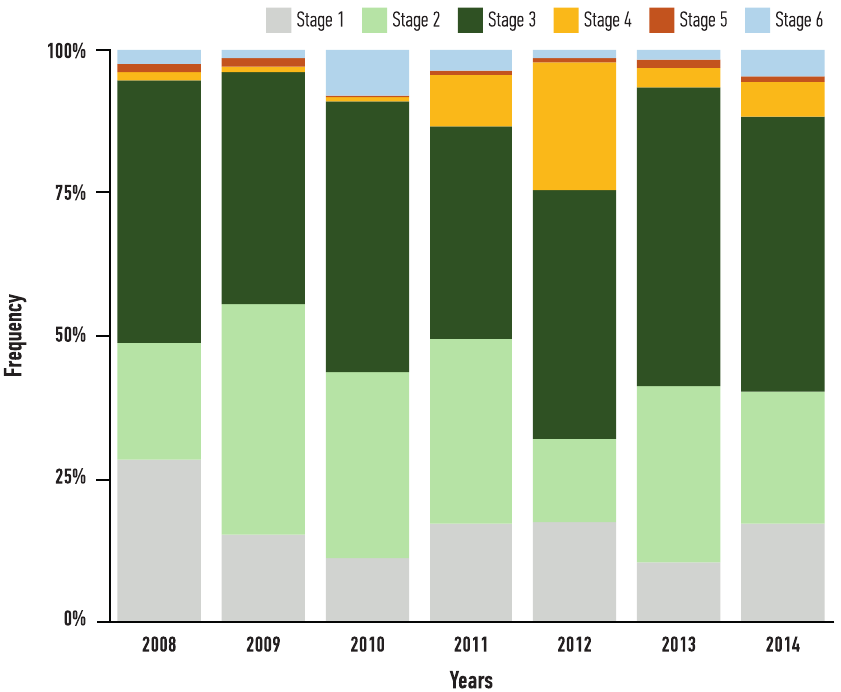
Figure 6. Temporal allocation of the developmental stages of Nephrops females from Pagasitikos Gulf, Eastern Mediterranean, Greece. Stage 1, white–immature; Stage 2, green, expands up to the cephalothorax–maturing; Stage 3, dark green, expands down into the abdomen–fully mature; Stage 4, white–ovigerous female carrying green eggs on its pleopods; Stage 5, white–ovigerous female carrying brown eggs on its pleopods; Stage 6, white–eggs are released with brown filaments on legs of the adult females.